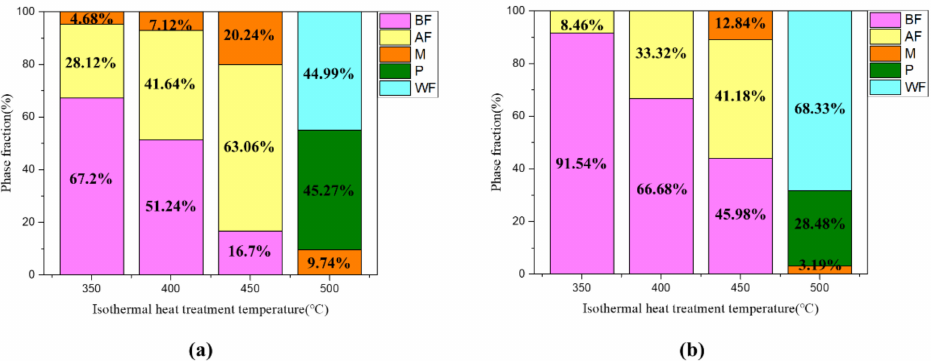
Figure 7. Phase fractions of ( a ) cast and ( b ) hot-rolled medium-carbon low-alloy steel after isothermal heat